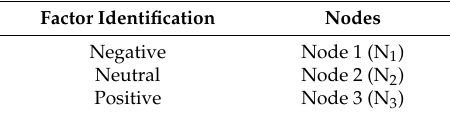
Table 6. Environmental Node classification with Nvivo